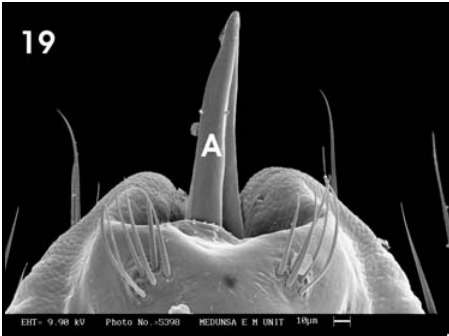
Fig. 19. The male showed the typical v-shaped pseudopenis